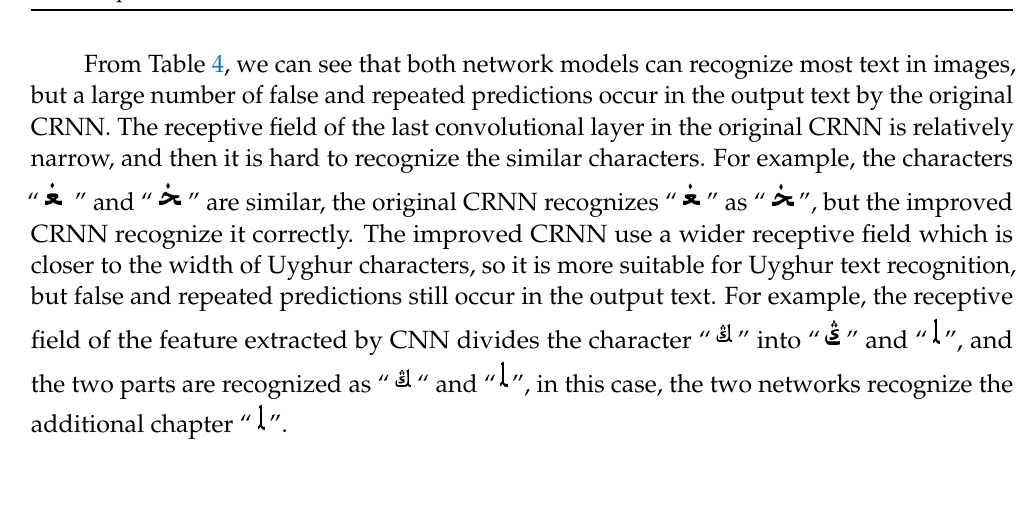
Table 4. Experimental results at 640 × 640 scale on the Total-Text dataset, Pre-Train represents whether to use the pre-training dataset for fine-tuning. “ Y ” means using pre-training, “ N ” means not using pre-training. “ P ” , “ R ” and “ F ” stand for “ precision ” , “ recall ” and “ F-measure ” respec- tively. Input Images